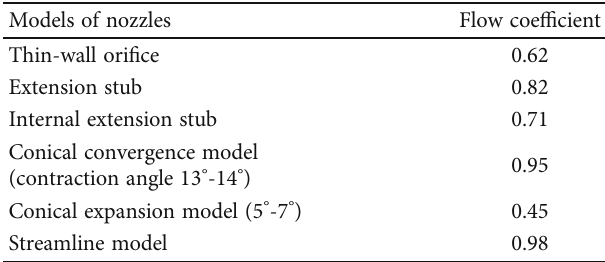
Table 8: The fl ow coe ffi cients under di ff erent models of